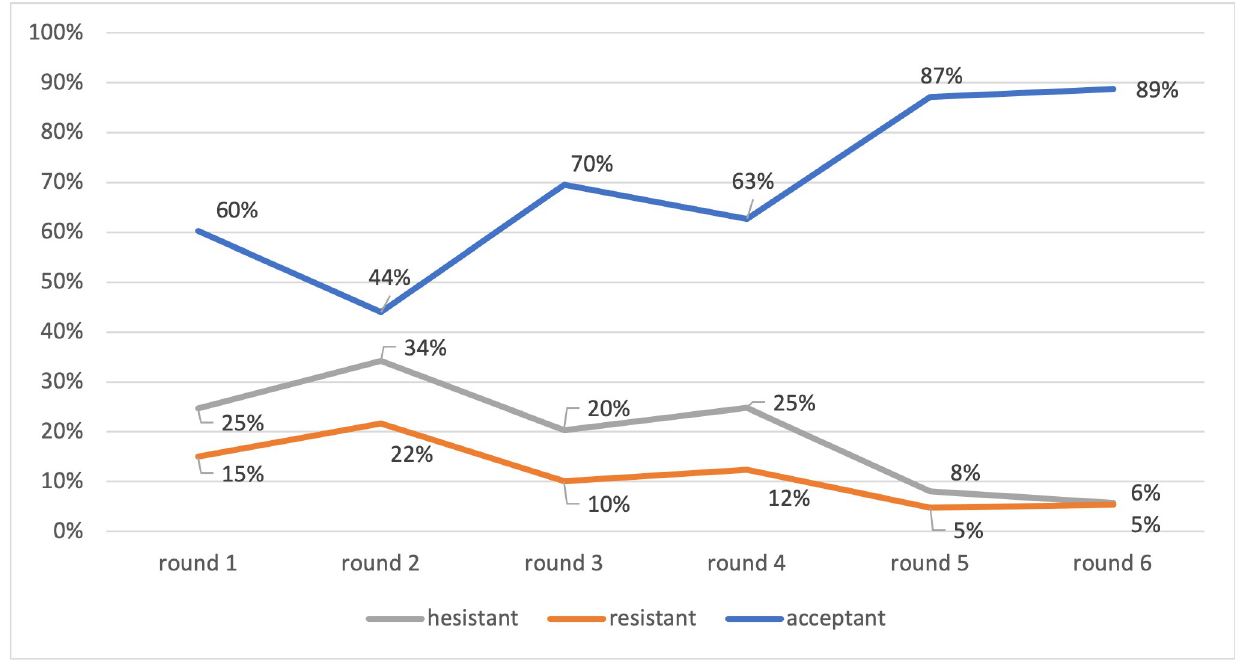
Fig 2. The trend of vaccine acceptance, hesitance and